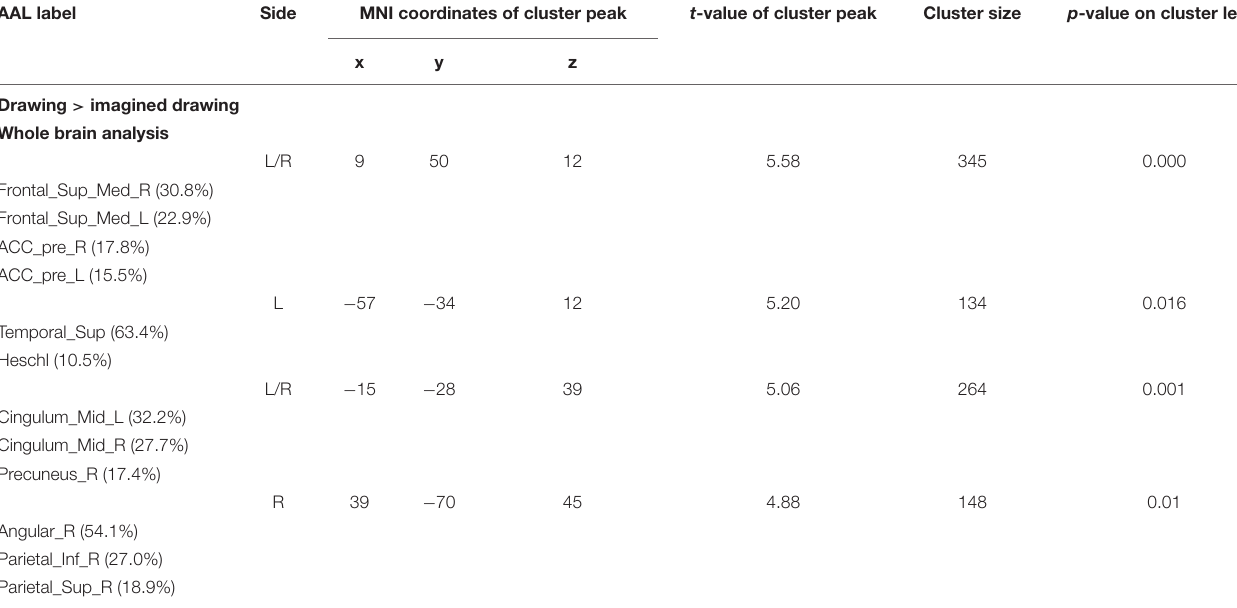
TABLE 4 | Results of the second level contrast drawing > imagined drawing on whole brain